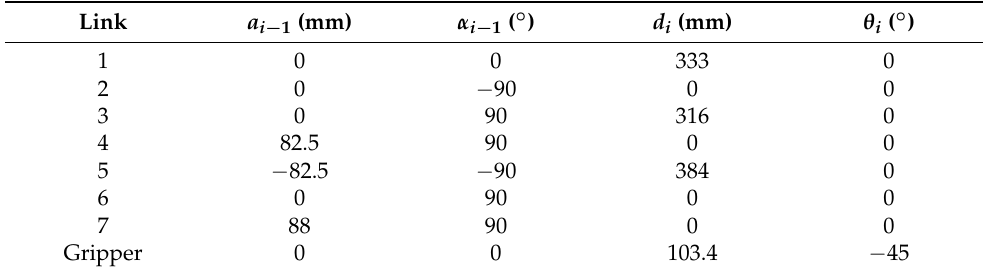
Table 1. DH parameters of the Franka Emika Panda robot.